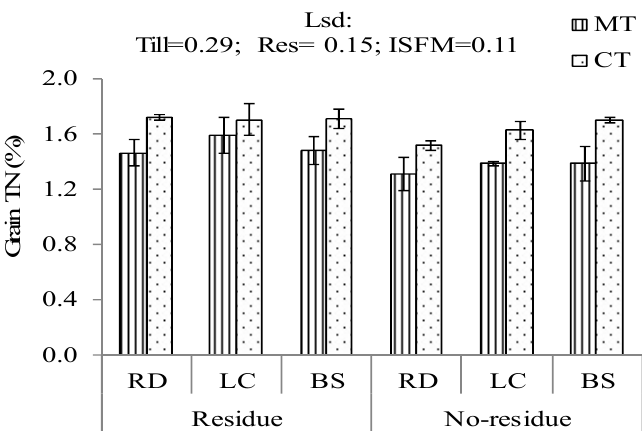
Figure 3. Management effect on grain total nitrogen (TN) content.